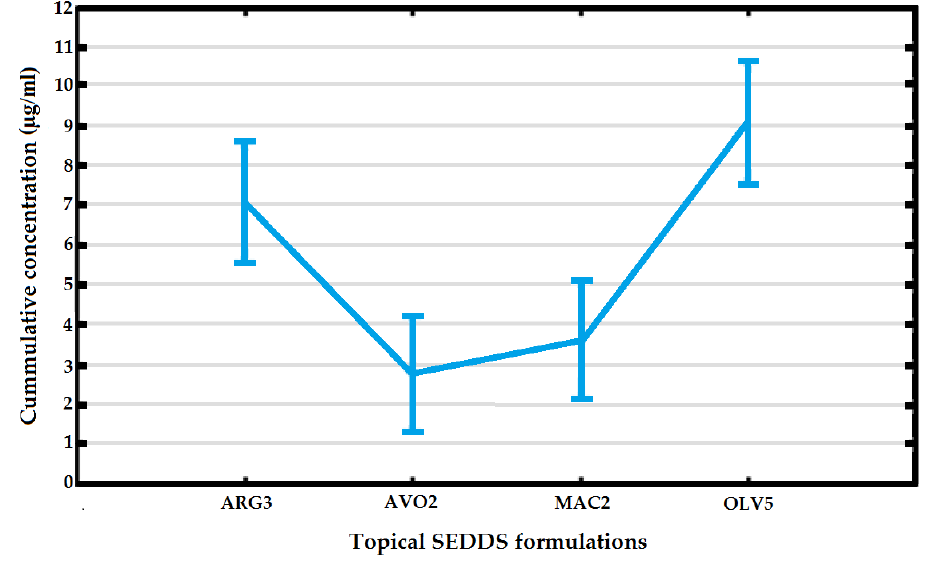
Figure 3. Cumulative clofazimine concentrations observed in epidermis-dermis.